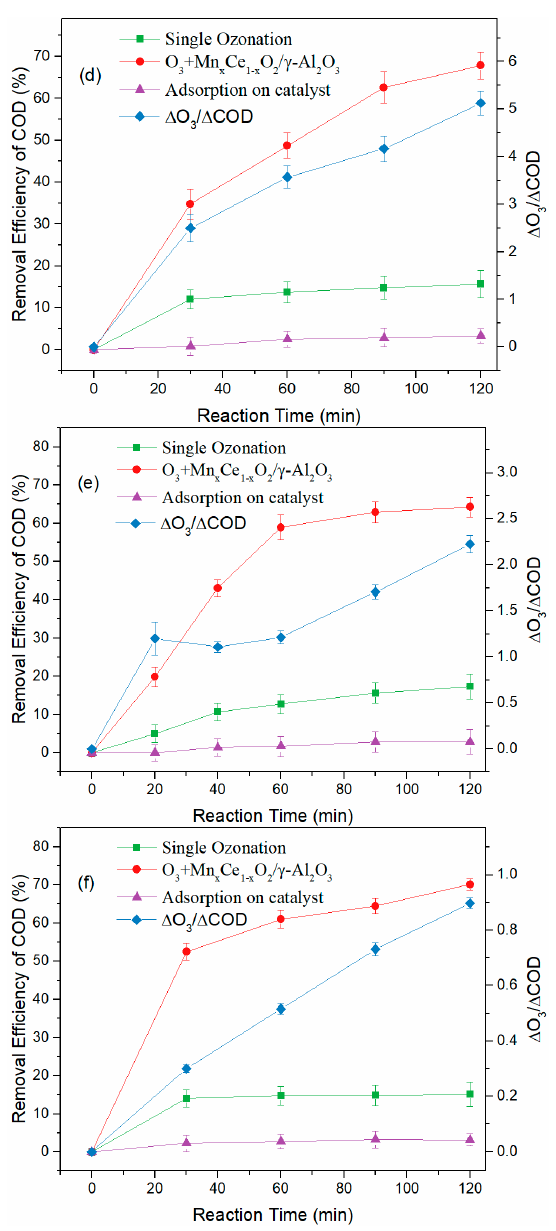
Figure 5. Δ O 3 / Δ chemical oxygen demand (COD) values during catalytic ozonation of BCW and COD removal efficiency in different process for the treatment of BCW from ( a ) B-A, ( b ) B-M, ( c ) F, ( d ) A, ( e ) J, and ( f ) X plant. (Experimental conditions: catalyst dosage, 180 g ∙ L − 1 ; ozone dosage, ( a ) 120 mg ∙ L − 1 ∙ h − 1 , ( b ) 210 mg ∙ L − 1 ∙ h − 1 , ( c ) 76 mg ∙ L − 1 ∙ h − 1 , ( d ) 200 mg ∙ L − 1 ∙ h − 1 , ( e ) 108 mg ∙ L − 1 ∙ h − 1 , and ( f ) 100 mg ∙ L − 1 ∙ h − 1 ; COD of influent, ( a ) 176.5 ± 4.5 mg ∙ L − 1 , ( b ) 218 ± 20 mg ∙ L − 1 , ( c ) 188 ± 7.0 mg ∙ L − 1 , ( d ) 115 ± 11 mg ∙ L − 1 , ( e ) 151 ± 8.5 mg ∙ L − 1 , and ( f ) 315 ± 4.0 mg ∙ L − 1 ).